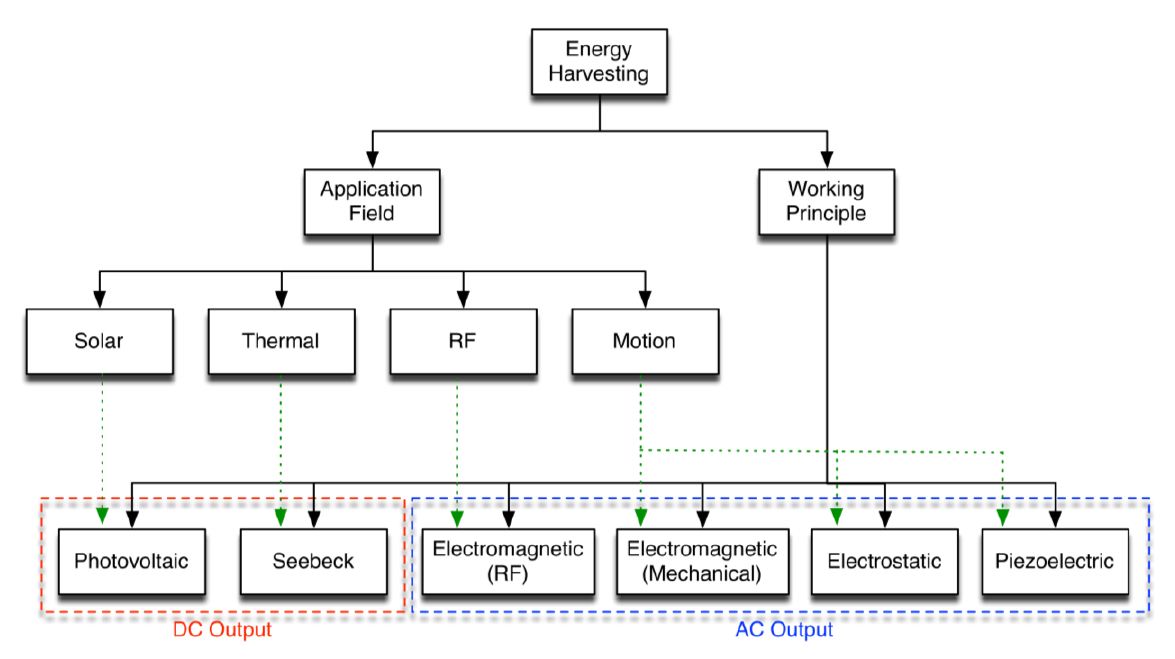
Figure 1. Hierarchy of main energy harvesting